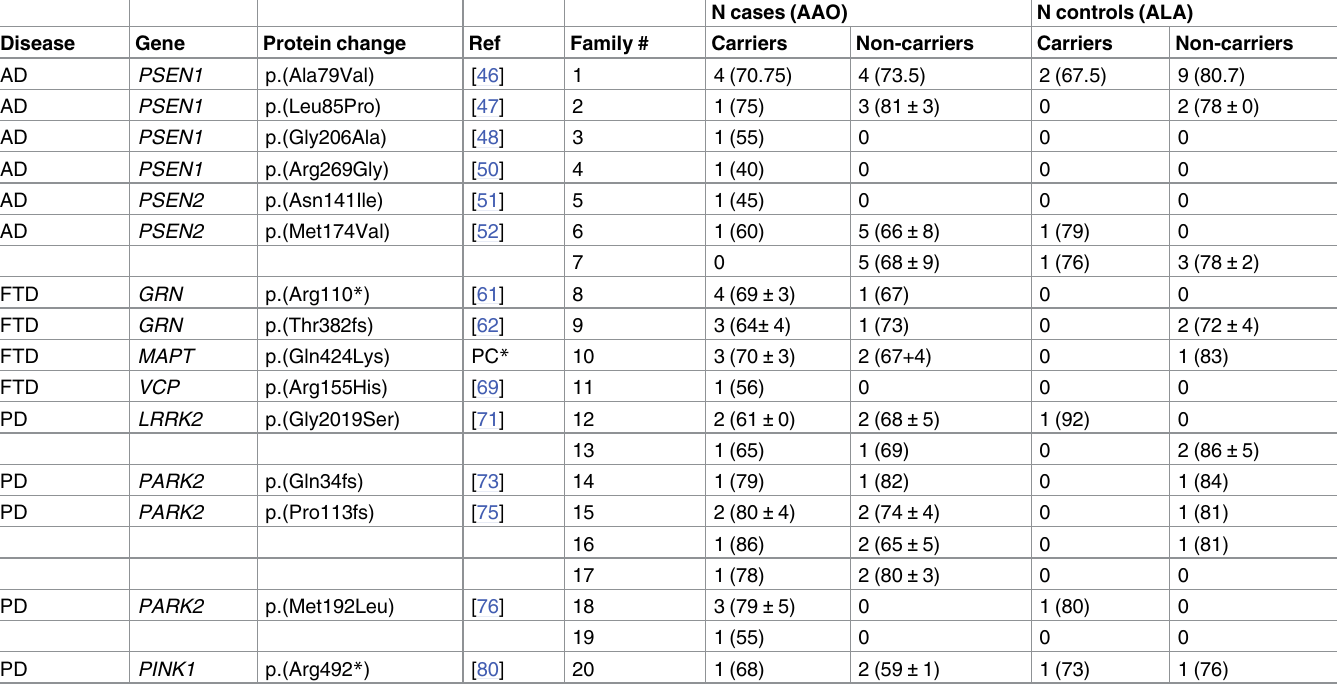
Table 2. Segregation pattern of reported pathogenic mutations detected in the familial cohort (452 families). The number of carriers and non-carriers in both affected and cognitivelynormalfamily members is displayed, along with the averageAAO for cases and averageALA for controls. The first reference for each variant is also